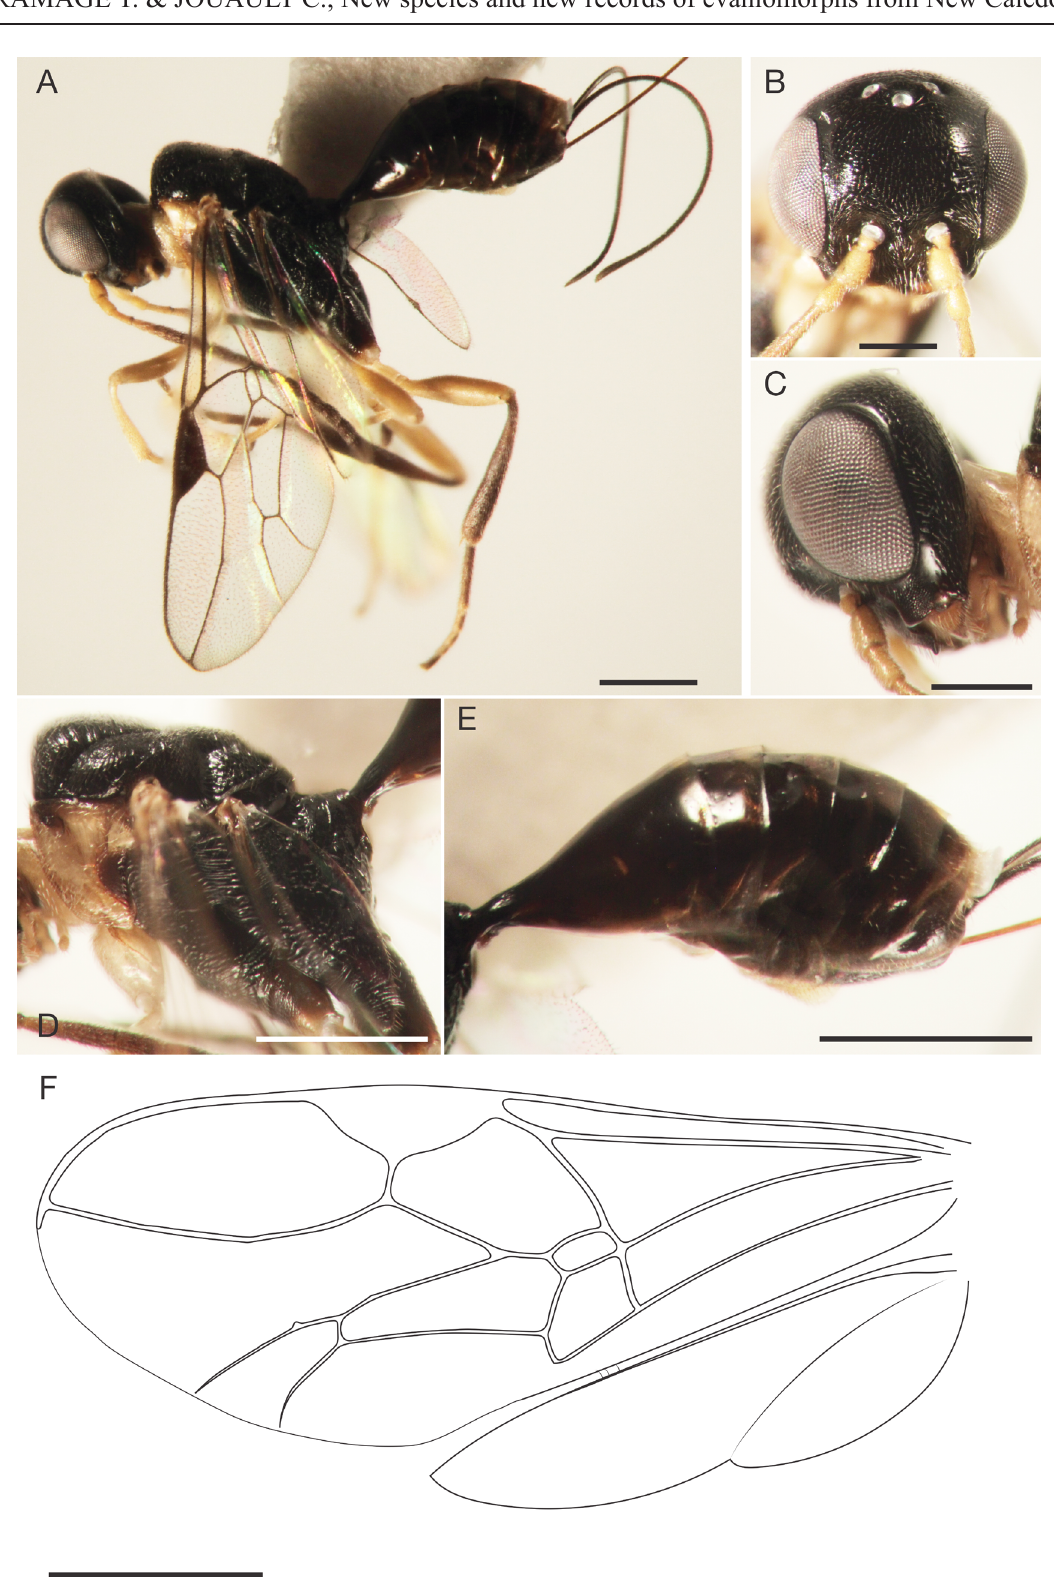
Fig. 1. Aulacus pascali sp. nov., holotype, ♀ (MNHN). A . Ateral habitus. B . Head in full-face view. C . Head in lateral view. D . Mesosoma in lateral view. E . Metasoma in lateral view. F . Line drawing of wings venation. Scale bars: A, D–F = 0.5 mm; B–C =